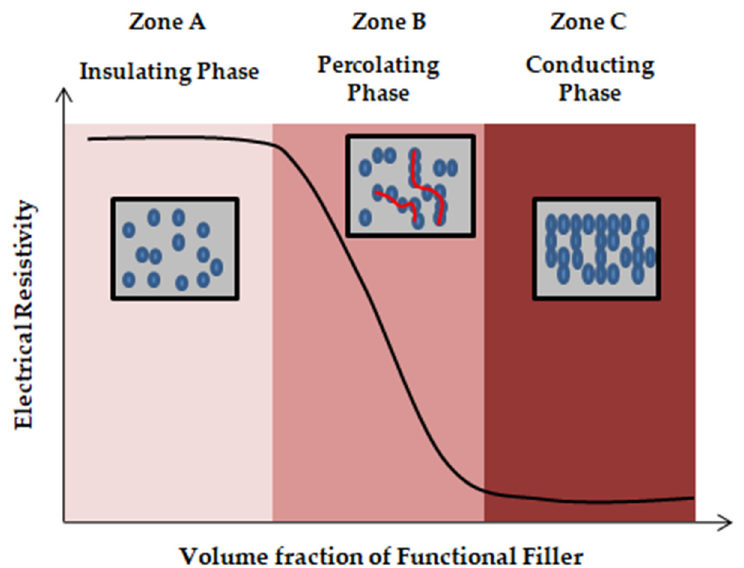
Figure 4. Percolation graph.